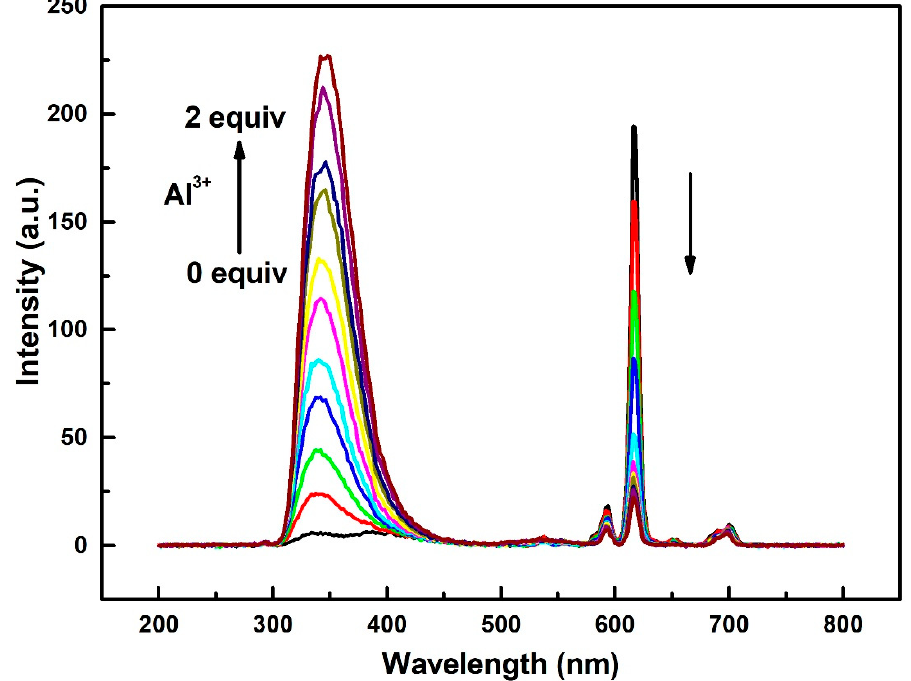
Figure 2. The emission spectra (excited at 292 nm) of compound 1 in DMF at room temperature in the presence of 0 to 2 equiv Al 3+ ions with respect to compound 1 . the presence of 0 to 2 equiv Al 3+ ions with respect to compound 1